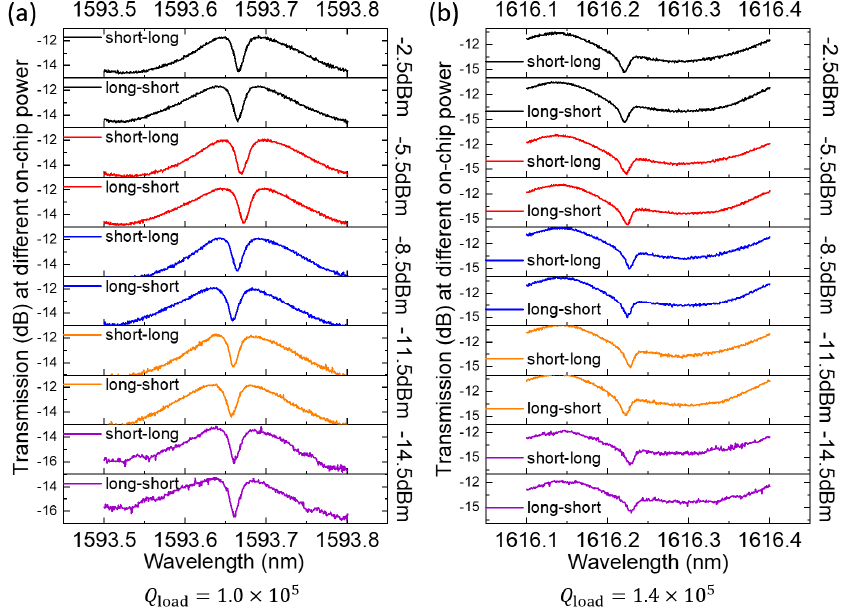
Figure 6. Measured transmission spectra of two different TE-polarized resonances under different on-chip input powers ( − 14.5 dBm ~ − 2.5 dBm) with different wavelength-scanning directions (i.e., from short (long) wavelength to long (short) wavelength) with loaded Q values of ( a ) 1.0 × 10 5 and ( b ) 1.4 × 10 5 , respectively.